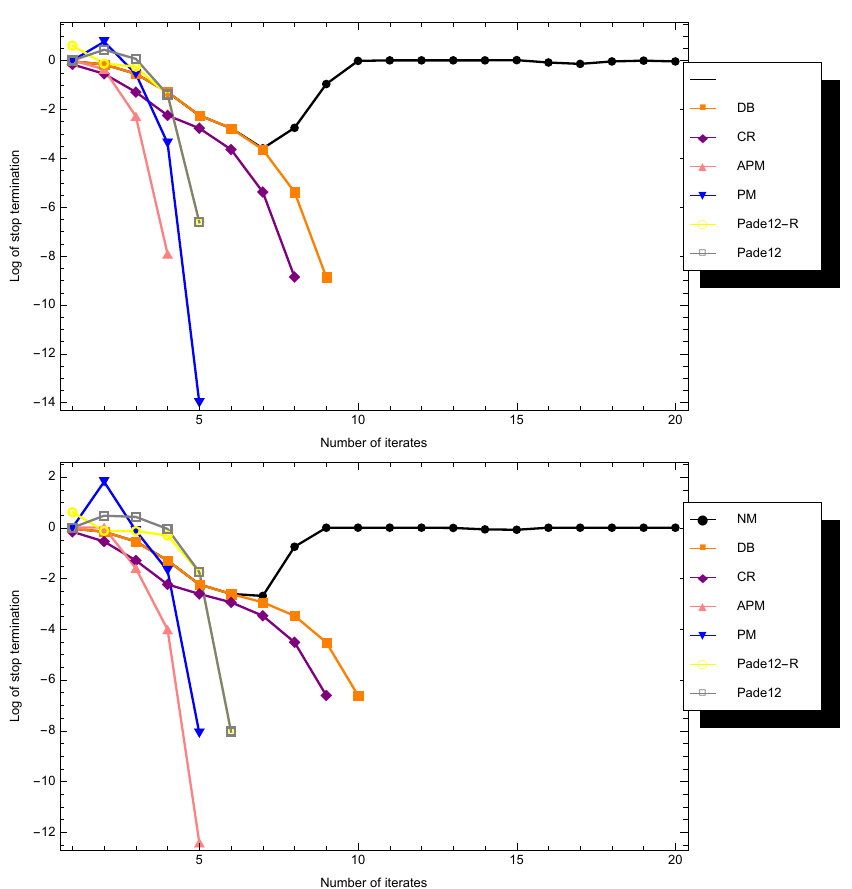
Figure 5. Numerical comparisons for finding the matrix square root in Example 1 when n = 300 at the top and n = 1000 at the